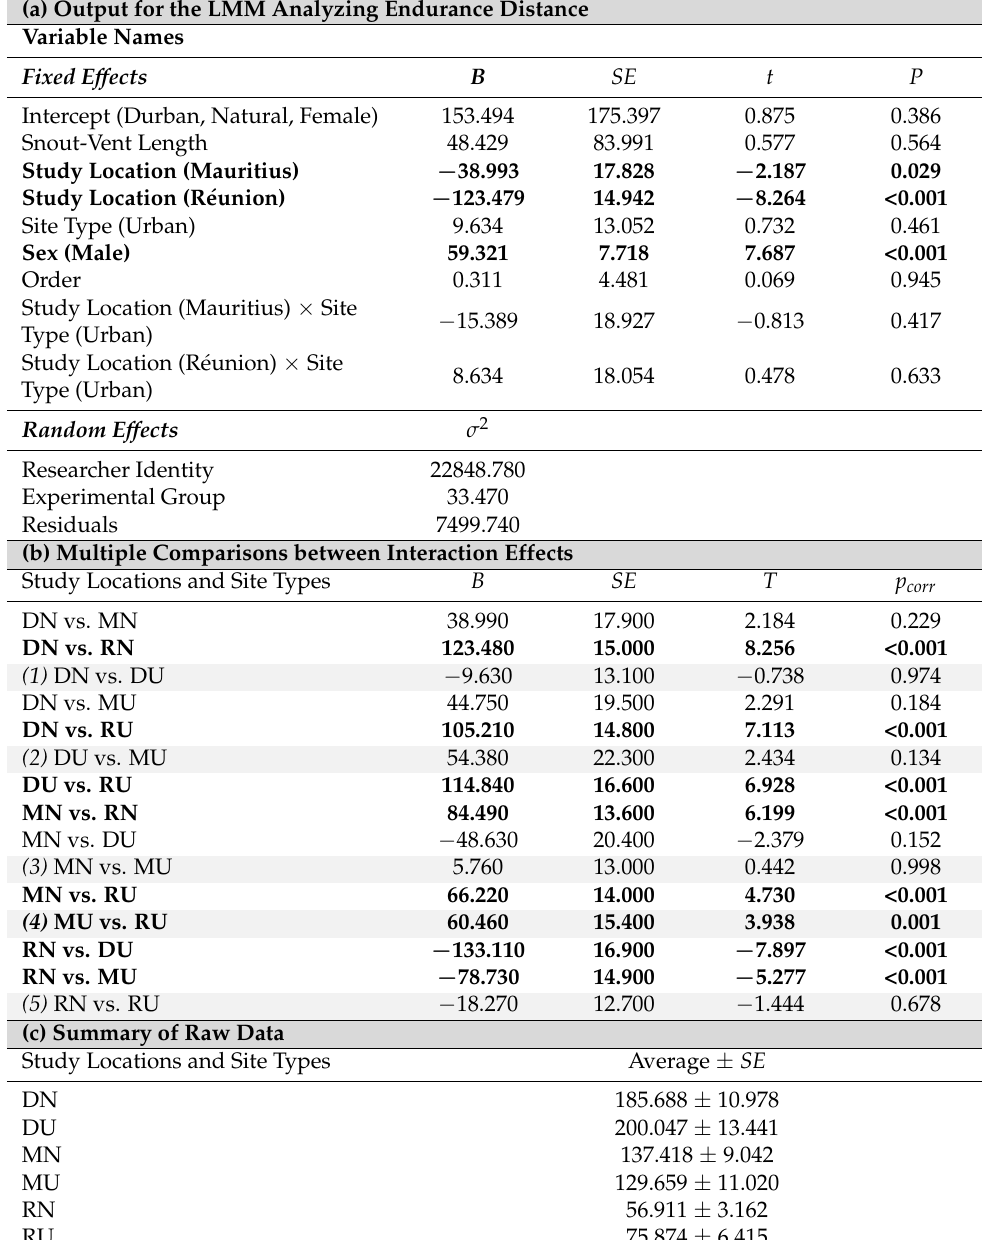
Table 7. ( a ) Outcome of the LMM examining differences in guttural toad ( Sclerophrys gutturalis ) endurance distance (m). Coefficient estimates ( β ) of fixed effects are presented with their standard errors ( SE ), variance estimates ( σ 2 ) are supplied for residuals and random effects, and all significant values ( p < 0.05) are bolded. Reference levels for each categorical variable are supplied in brackets following the variable name. ( b ) Post hoc multiple comparisons of endurance distance between all interaction effects of study location (i.e., Durban = D, Mauritius = M, and R é union = R) by site type (i.e., natural = N and urban = U) and p -values ( p corr ) were corrected using an “ mvt ” adjustment [63]. The stages of the hypothesized invasion route are numbered and highlighted in gray. ( c ) Summary statistics (average ± SE ) of the raw data for each study location and site type